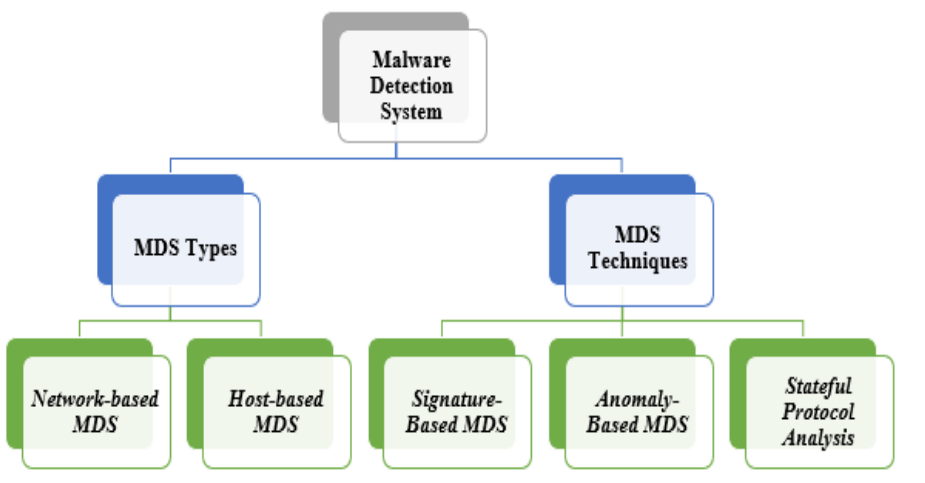
Figure 4. MDS types and techniques.